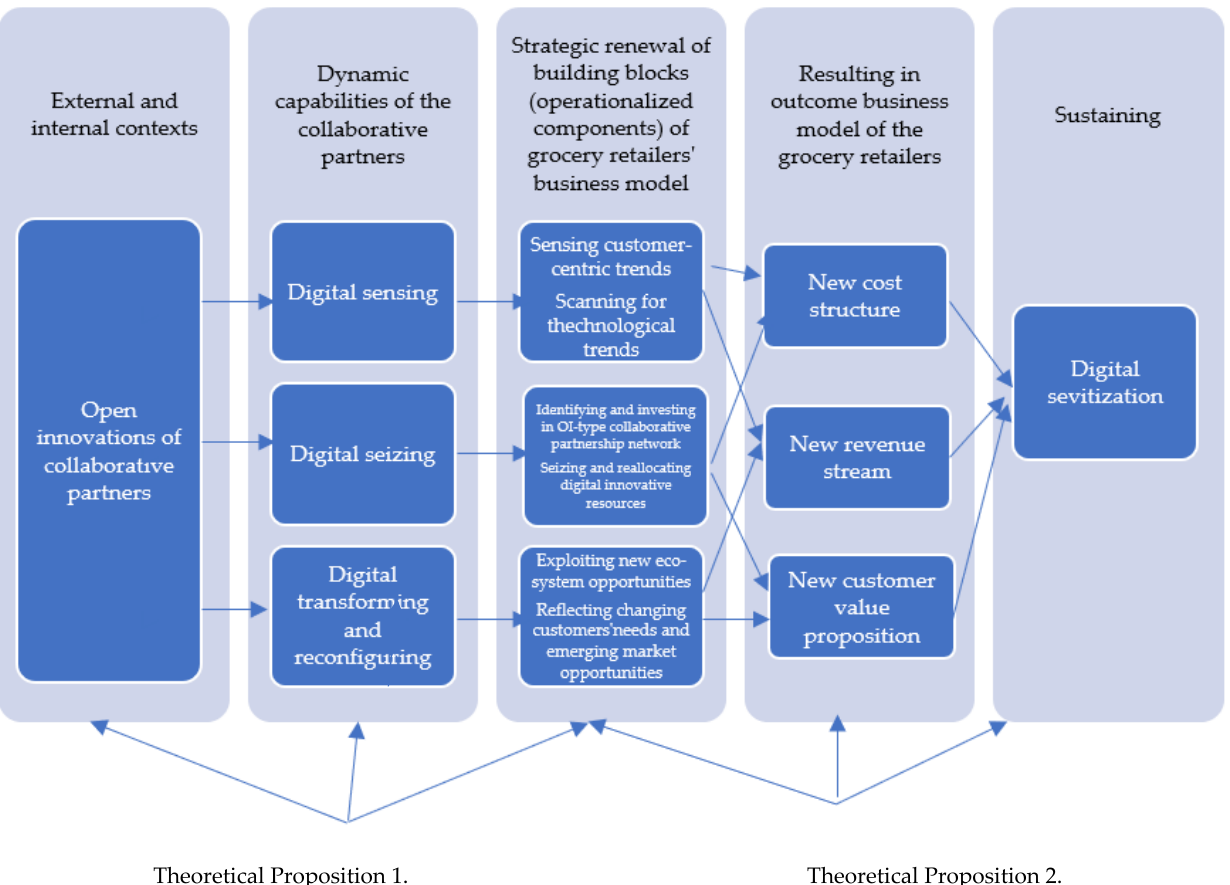
Figure 1. The conceptual model of current research. Adopted from Č irjevskis (2019) and